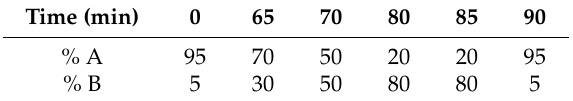
Table 3. Liquid chromatography-tandem mass spectrometry (LC-MS/MS) results. Time